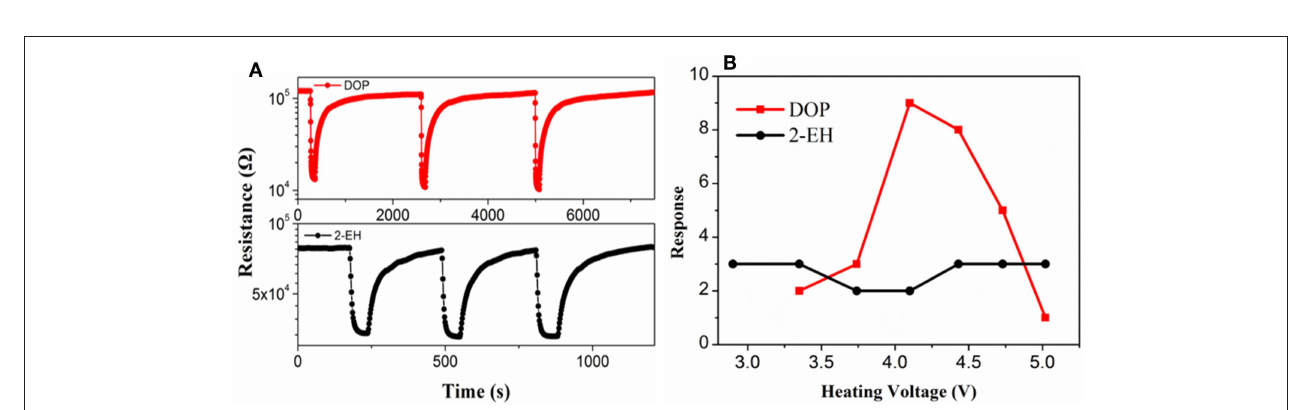
FIGURE 4 | (A) Response transients and (B) response values of the TGS-822 sensor to 100 ppm vapors of DOP and 2-EH standards.